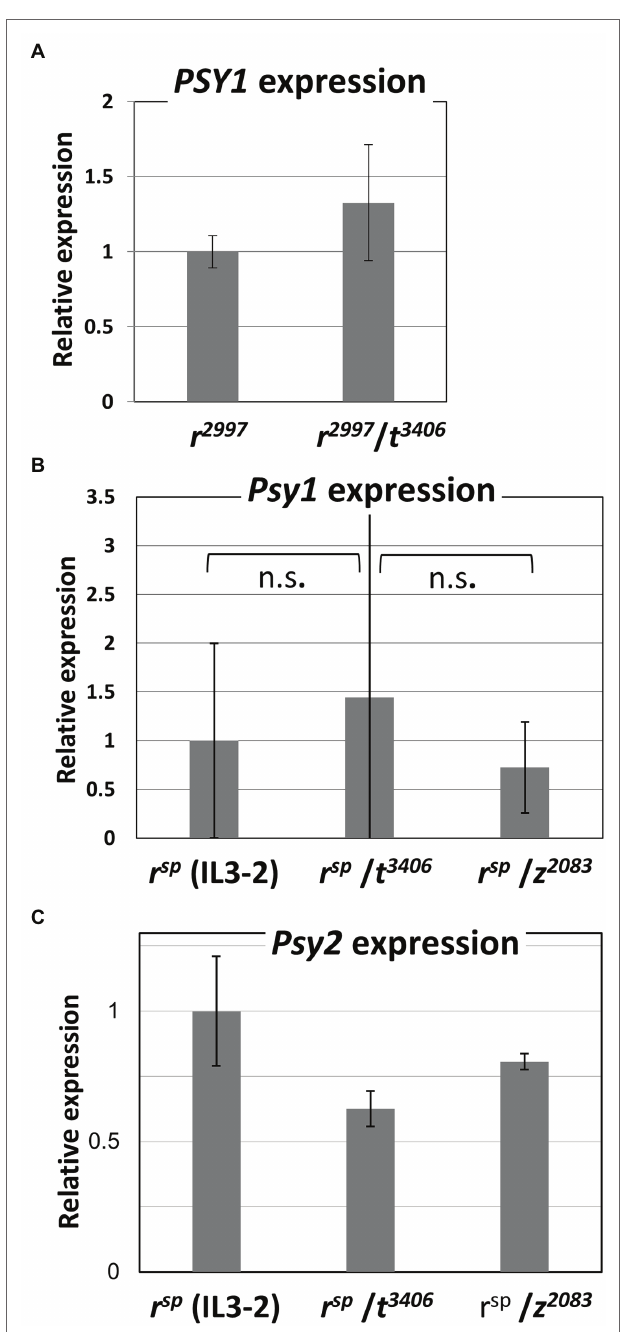
FIGURE 3 | Expression of PSY genes in fruits. (A) PSY1 transcript levels at the “breaker” stage of r 2997 and r 2997 / t 3406 ; (B) PSY1 transcript levels at the “breaker” stage of r sp , r sp / t 3406 and r sp (introgression line IL3-2)/ z s 2083 ; (C) PSY2 transcript levels in r sp , r sp / t 3406 and r sp / z 2083 . The data were compared using the “Compare all pairs” (Tukey–Kramer), p < 0.05. n.s. no